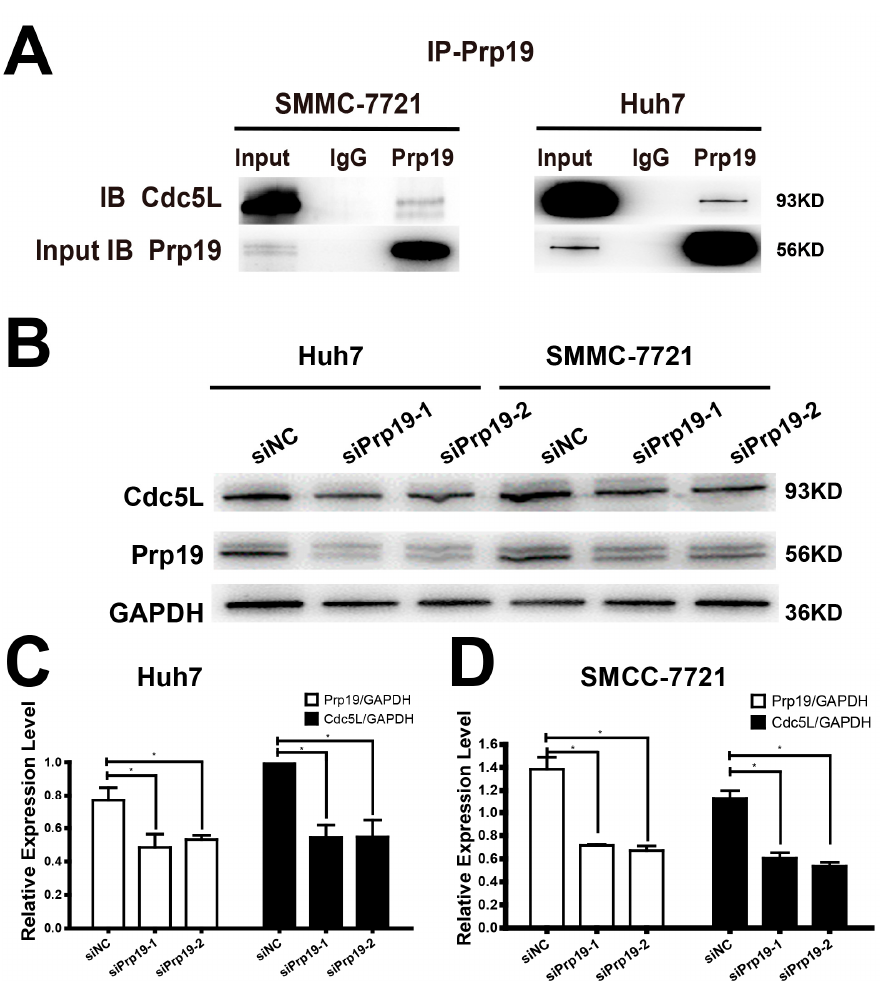
Figure 2. Prp19 binds with Cdc5L and modulates Cdc5L expression in HCC Cells. ( A ) Endogenous interaction between Prp19 and Cdc5L was detected in Huh7 and SMMC-7721 cells; ( B ) Reduction of Cdc5L expression in HCC cells transfected with siRNAs targeting Prp19; ( C , D ) The bar charts demonstrate the densitometry ratio of Prp19 or Cdc5L protein to GAPDH (loading control) (* p < 0.05). The data are mean ± SD of three independent experiments. NC, control